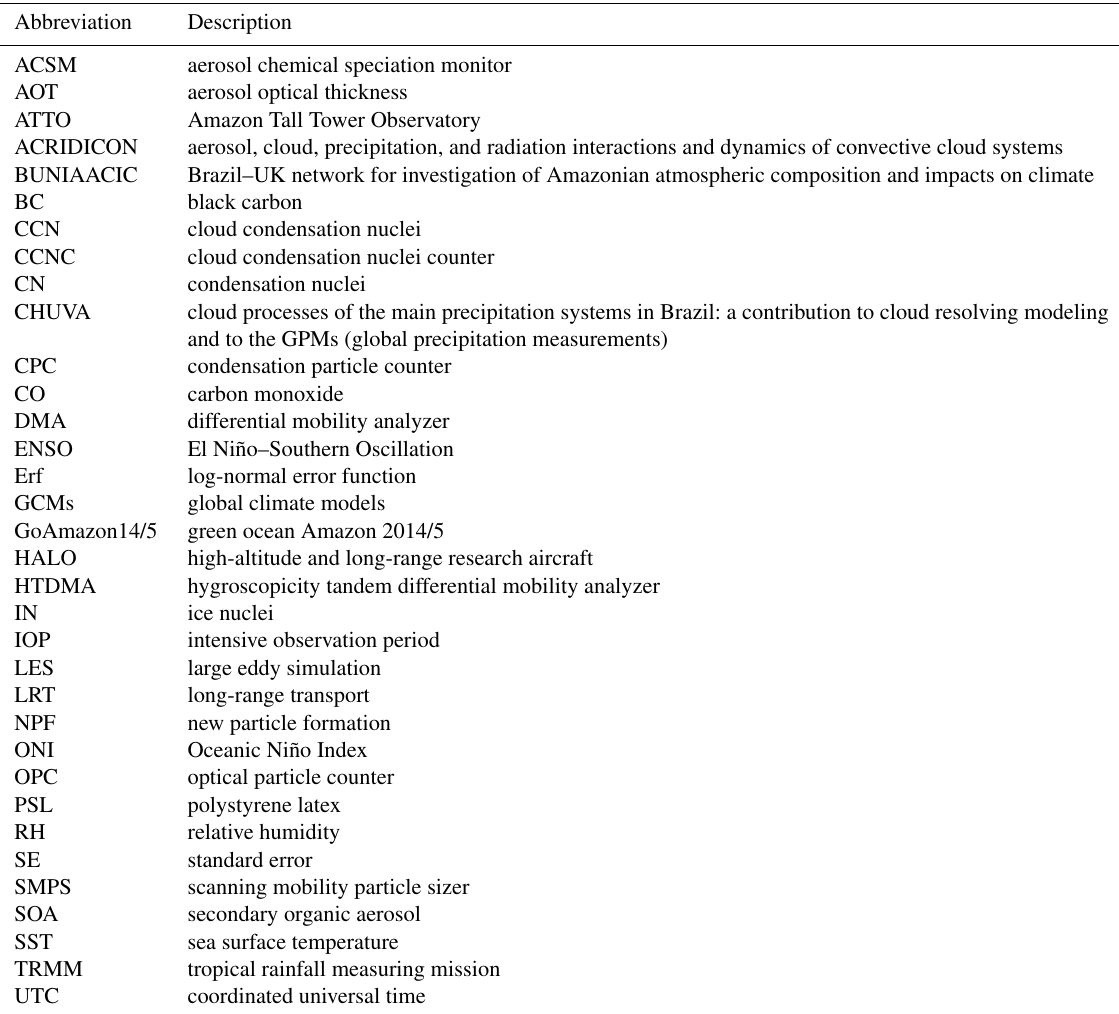
Table A2. List of